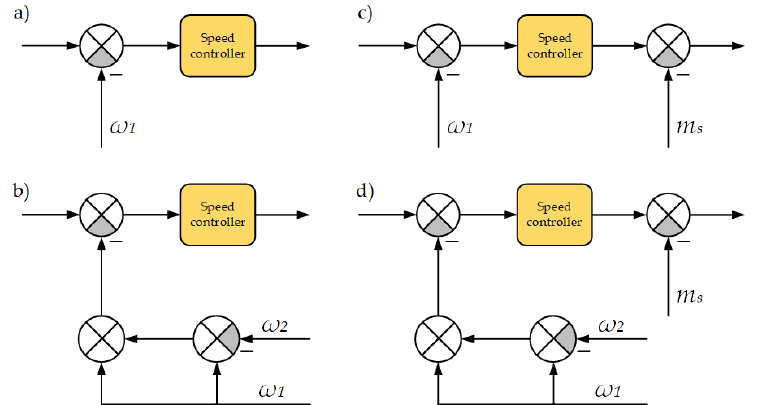
Figure 15. Combinations of feedbacks applied in the control structure, a classical feedback loop ( a ), an additional speed difference feedback ( b ), an additional shaft torque feedback ( c ) and a combination of speed and torque feedbacks ( d ).